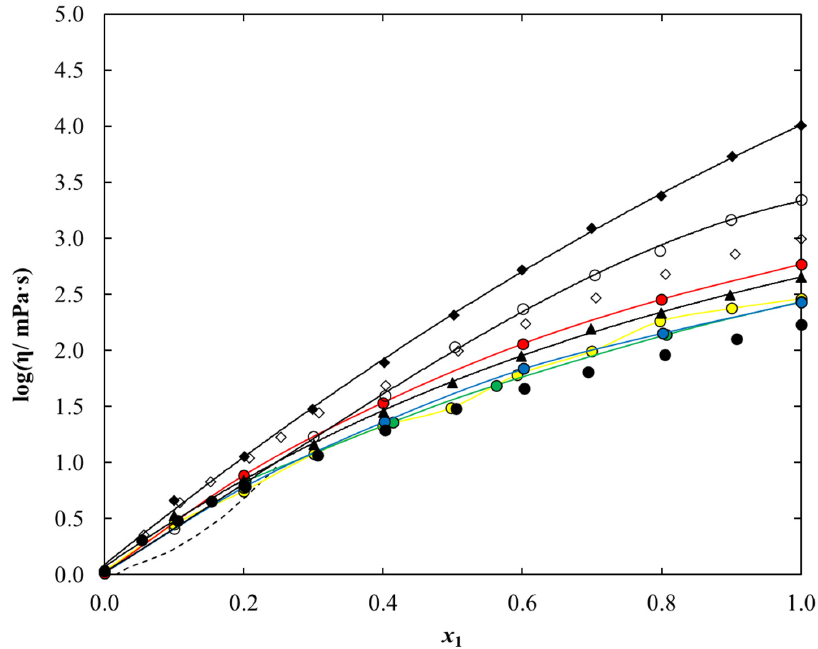
Figure 8. Experimental and calculated dynamic viscosity data of {Dimethyl Phosphate –Based IL (1) + Ethanol (2)} system vs. ionic liquid mole fraction, x 1 , at T = 298.15 K: ♦ , [C 1 C 2 MOR][DMP] (this work); ○ , [C 1 C 2 PIP][DMP] (this work); ▲ , [N 1,2,2,2 ][DMP] (this work); ● , [C 1 C 1 IM][DMP] [54]; ● ,